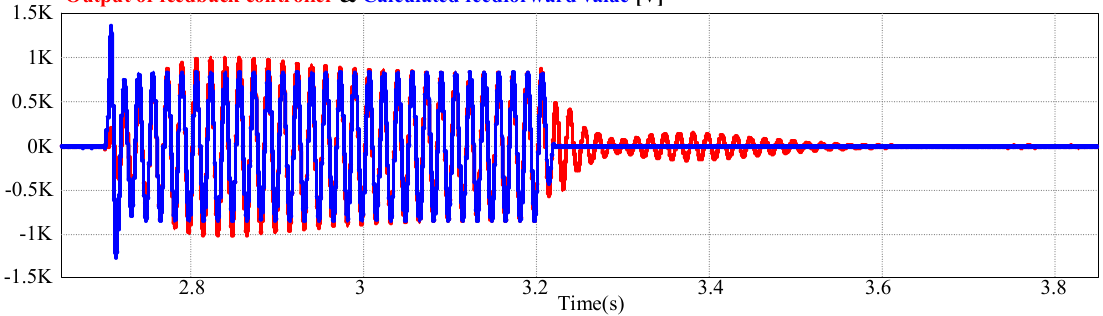
Figure 9. Comparison of the zero-sequence voltage of the leg balancing feedback controller without the feedforward term and the calculated feedforward term from the proposed method under unbalanced grid conditions.